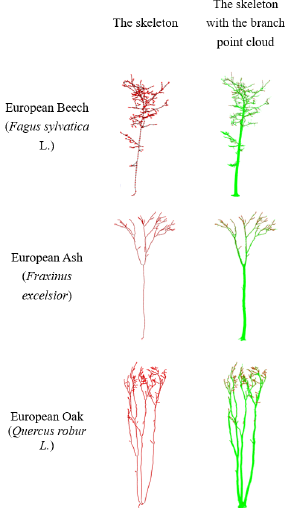
Figure 9. Verification on public tree point clouds.